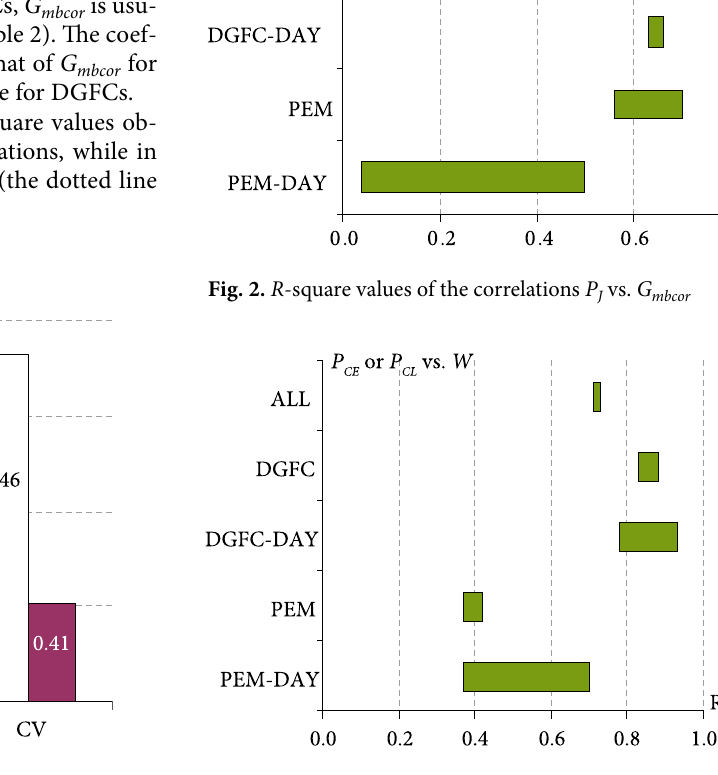
Fig. 1. Main statistics of P CE and G mb compared Table 3. R -square values (all the mixes)